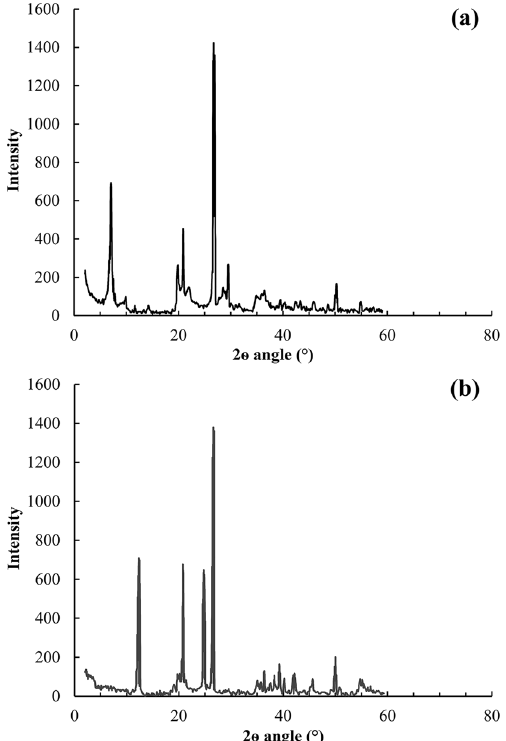
Fig. 2 XRD graph of fine grained additives used in mixtures: a bentonite powder, b kaolinite